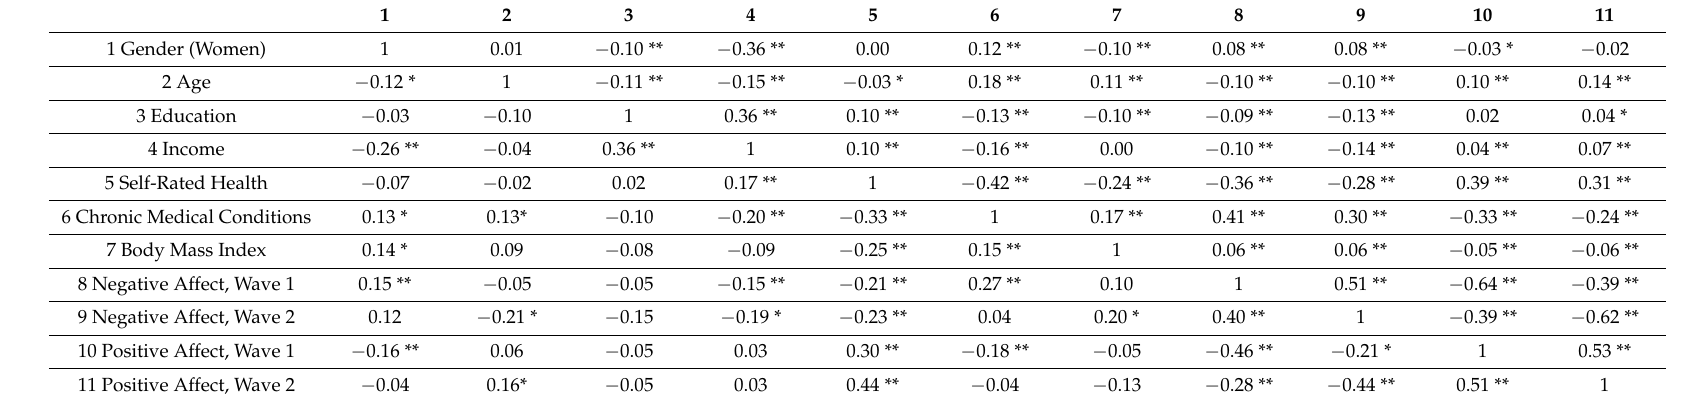
Table 2. Correlation matrix of the study variables in White and Black